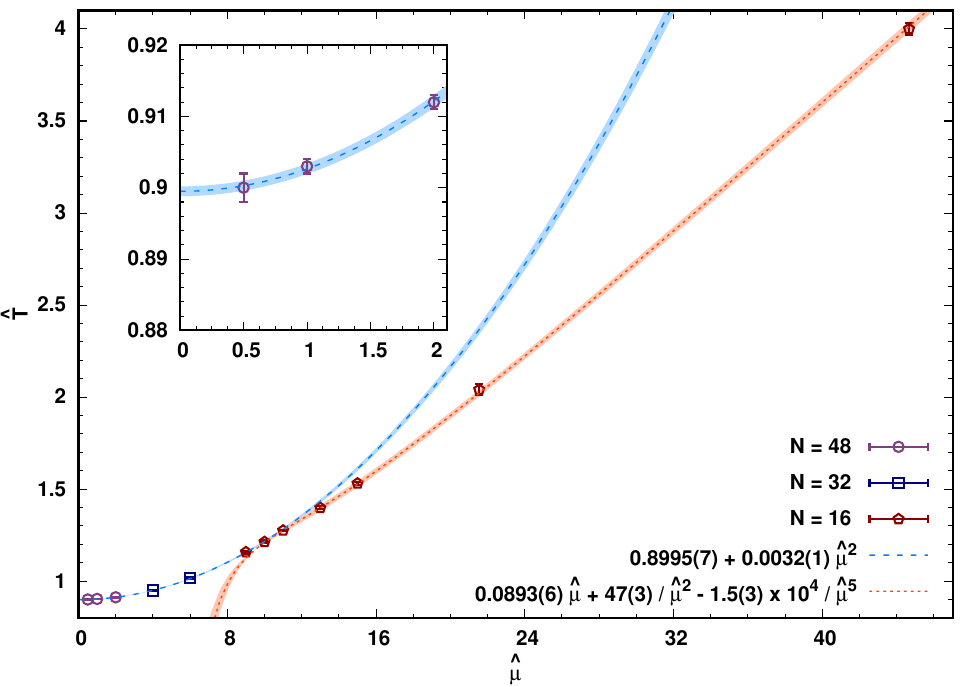
Figure 6. The b T – µ phase diagram of the bosonic BMN model from our N τ = 24 results for b T c b computed with N = 16 , 32 and 48 . The red curve shows our fit of the µ ≥ 10 results to eq. (3.7), while b the blue curve shows our fit of the µ ≤ 10 results to eq. (3.8). Our results self-consistently b